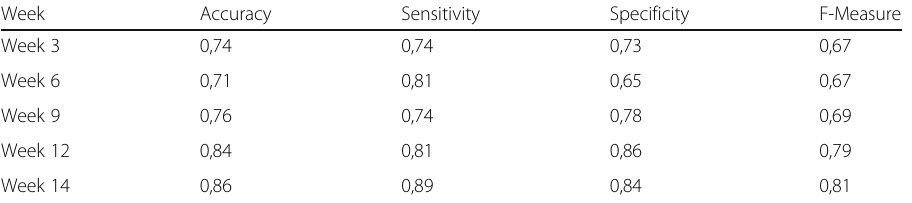
Table 12 Analysis Results Regarding Classification Models Established through Data Obtained in Different